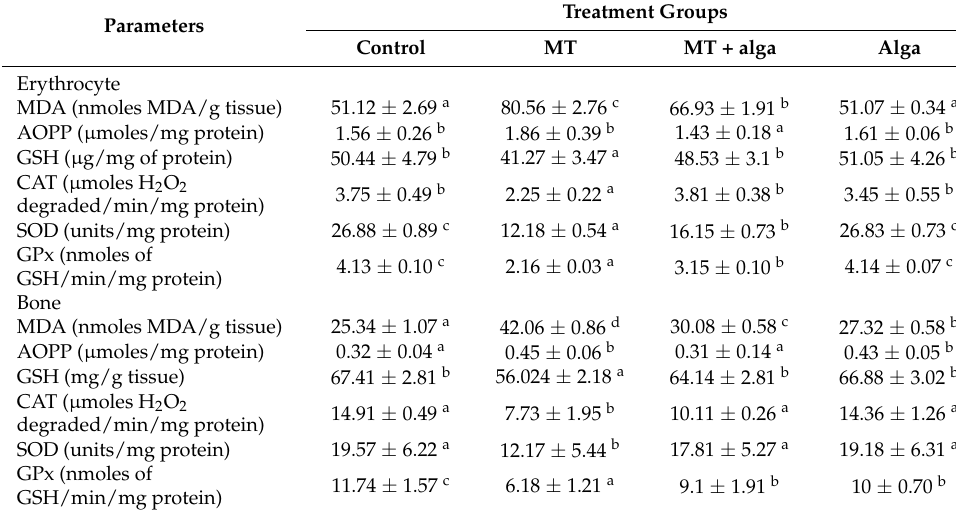
Table 5. Oxidative stress markers in erythrocytes and bone of adult rat controls and treated with MT, alga or their combination (MT + alga) for 7